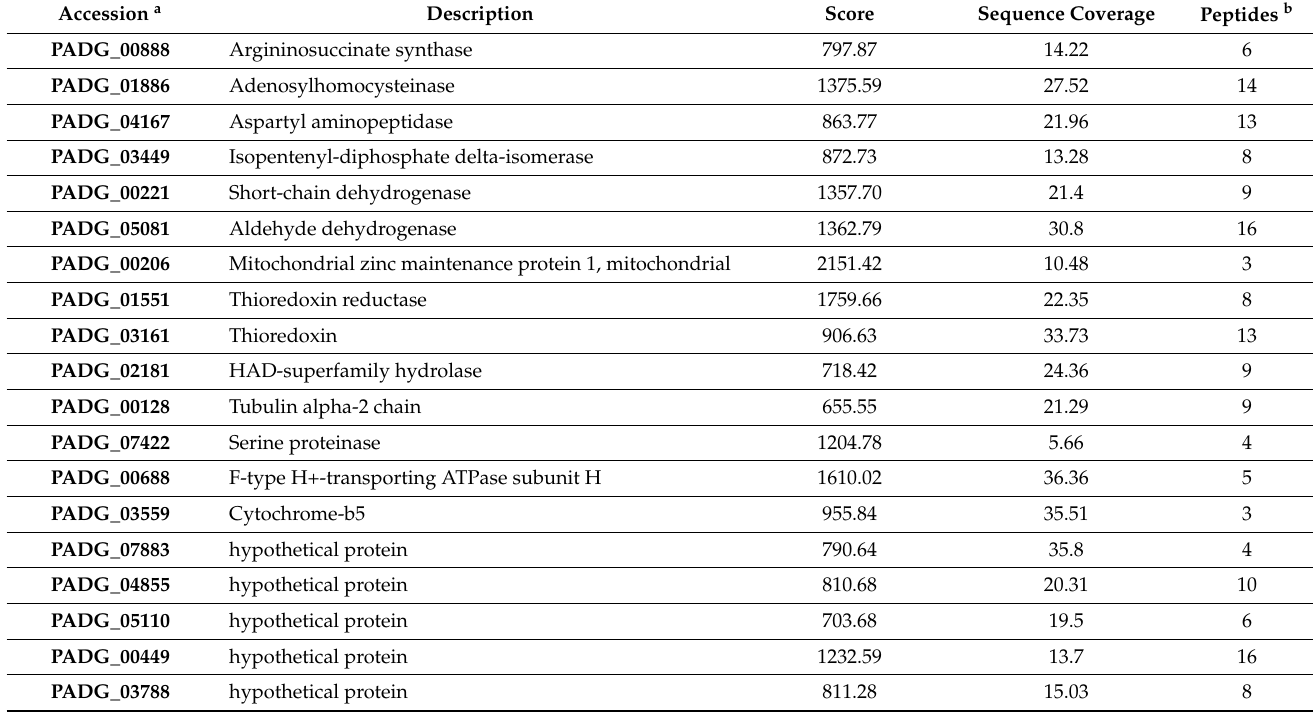
Table 1. Pb ATX—interacting proteins by using pull-down assays identified through